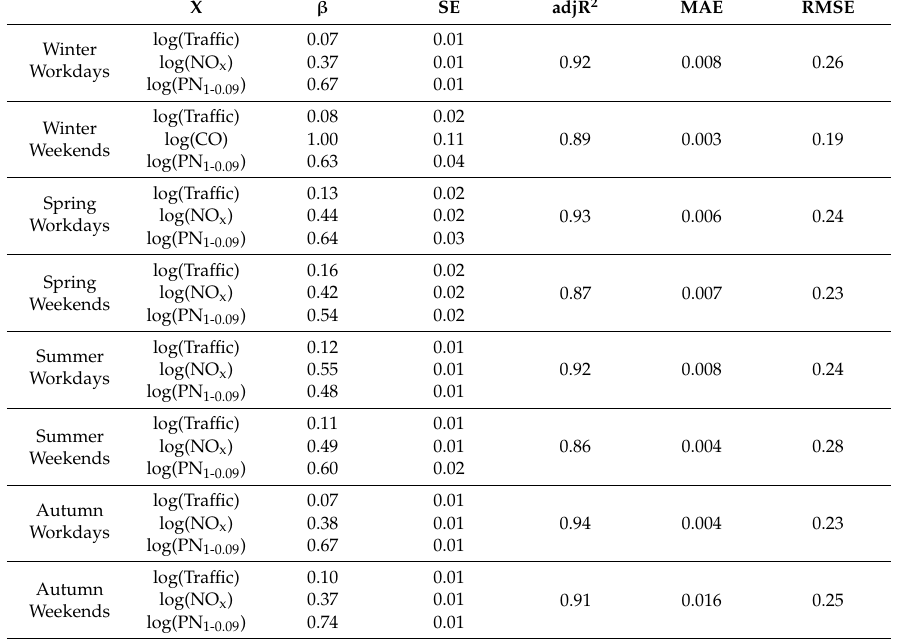
Table 4. Best performing OLS regression traditional proxy results in the street canyon in Mäkelänkatu (all models and all coe ffi cients of the corresponding input variables have p < 0.05). X represents the predictor variables in the di ff erent classes. β and SE are the coe ffi cients of the estimates and the corresponding standard errors, respectively.